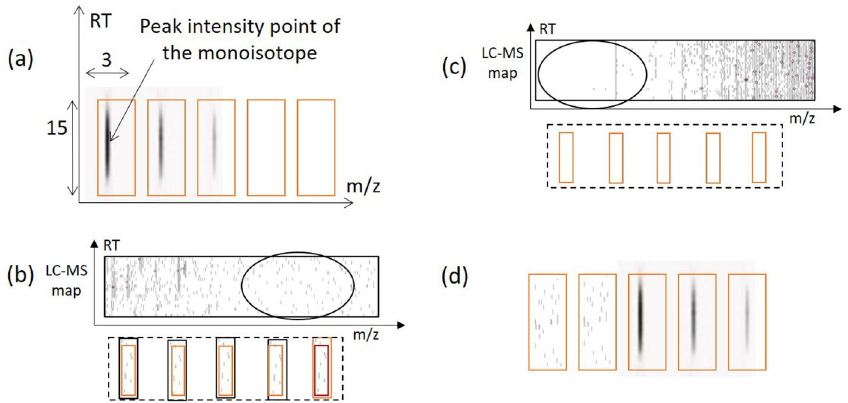
Figure 11. ( a ) A sequence of five frames, first three holding three isotopes. Each frame has dimension [ 15 × 3 ] , covering 15 scans along the RT axis and 0.03 m / z along the m / z axis (each pixel represents 0.01 m / z ). We filter out isotopic signals from the background by taking the intensity within the range of 2 ppm before and after the peak intensity m / z value, and 7 scans before and after the peak intensity RT value. The signal is left aligned with the frame. ( b ) A sequence of five frames which is generated from noisy areas in LC-MS map. ( c ) A sequence of five frames which is generated from blank areas in LC-MS map. ( d ) A sequence of five frames where the initial frames are holding noisy traces.